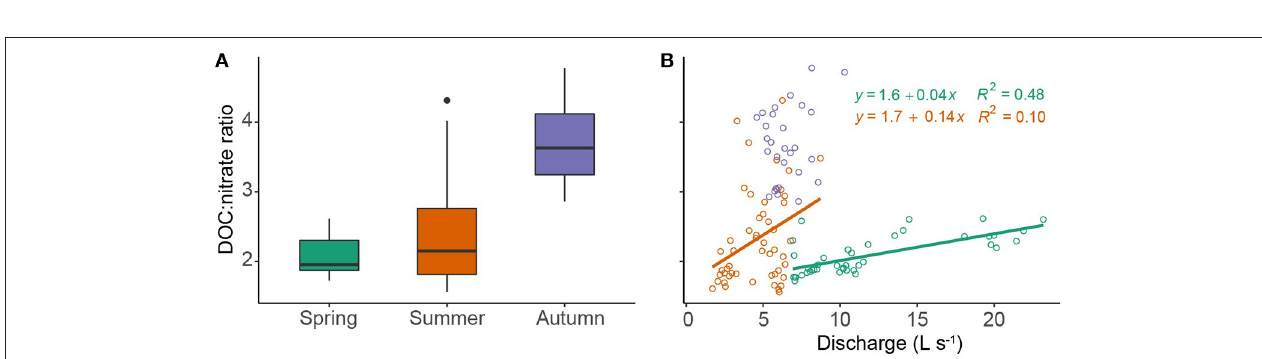
FIGURE 6 | Hourly mean ( ± 95% CI) measurements for NO − 3 -N and DOC mass balance during spring ( n = 900 for NO − 3 -N and 903 for DOC), summer ( n = 692 for NO − 3 -N and 618 for DOC) and autumn ( n = 659 for NO − 3 -N and 658 for DOC).